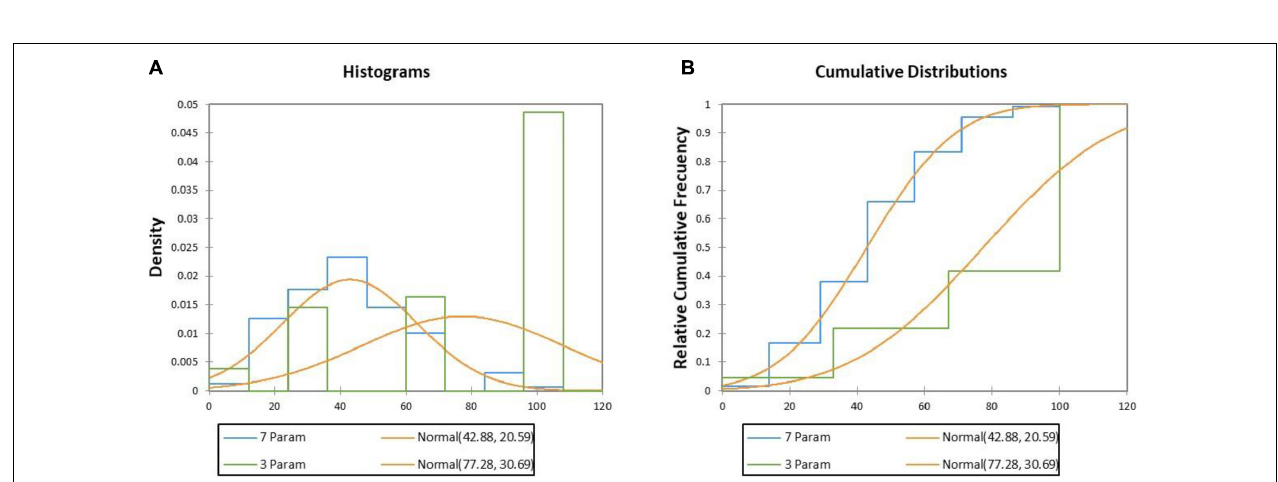
FIGURE 11 | Relative (left panel A ) and cumulative occurrence (right panel B ) of vulnerability levels for beaches along the Spanish Mediterranean coast after the impact of storm Gloria (January 2020). The number of beaches affected, given by frequencies in the vertical axes of the two panels, and the different levels of risk, indicated by the variations in shape between the orange (vulnerability from 7 indicators) and blue (vulnerability from 3 indicators) lines, indicate how the analysis depends on the approach selected. The calculated frequencies have been fitted to a Normal distribution, whose parameters appear between